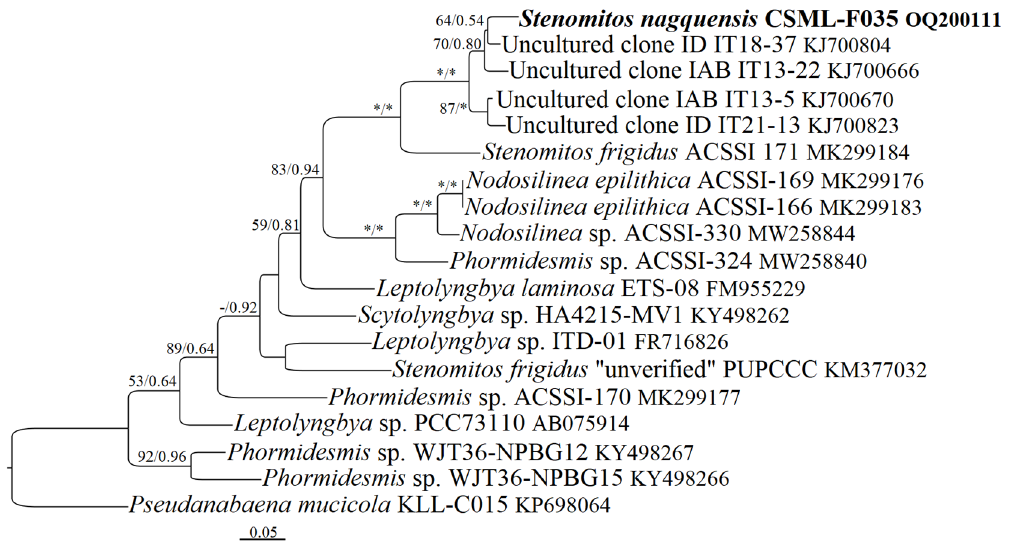
Figure 5. Maximum-likelihood phylogenetic tree based on the rbcL gene, with node support from ML and Bayesian inference. Bootstrap and posterior probability values from 99 to 100 are represented by asterisks (*). The novel species is written in bold.